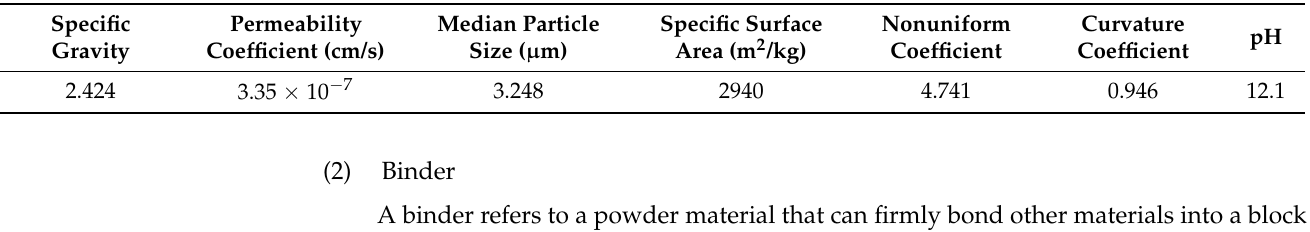
Table 1. Physical properties of red mud from the Bayer process.